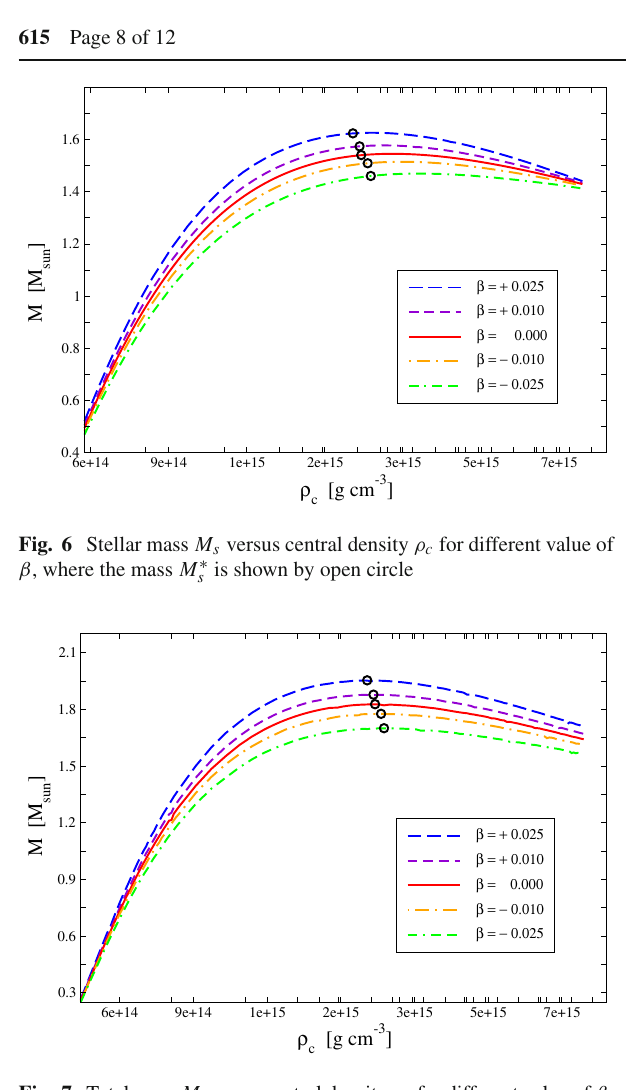
Fig. 7 Total mass M versus central density ρ c for different value of β , where the maximal mass M ∗ is shown by open